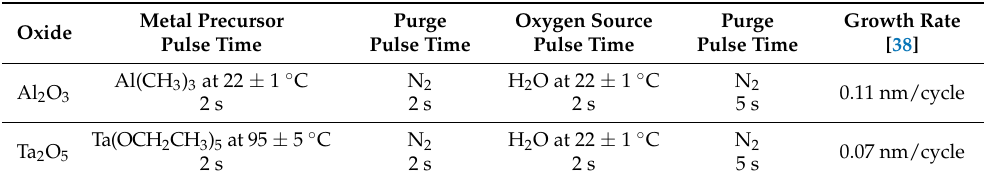
Table 1. Atomic layer deposition parameters for Al 2 O 3 and Ta 2 O 5 in a flow-type in-house-built reactor on Si (100) wafer at 300 °C.